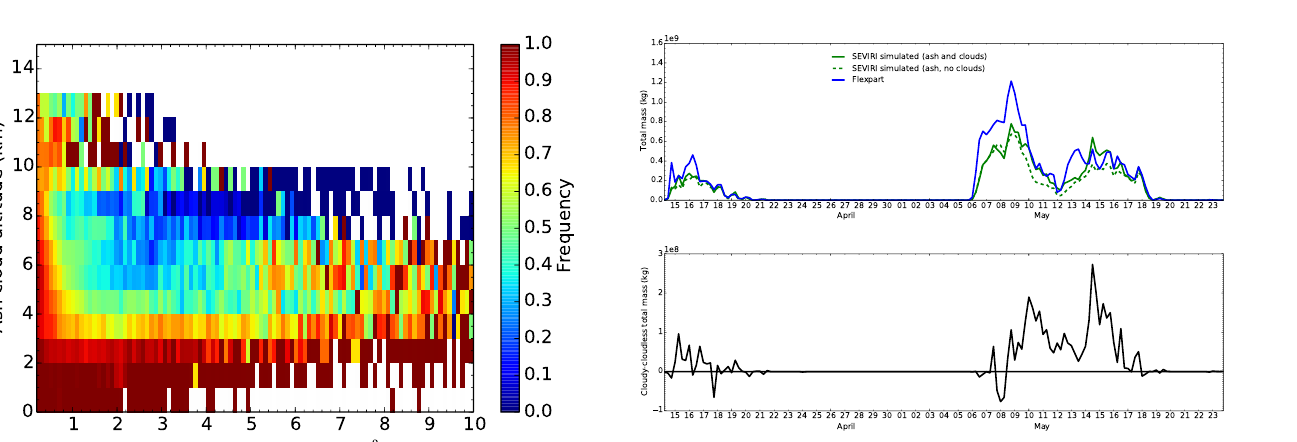
Figure11. AshretrievaltimeseriesfortheEyjafjallajökull2010eruption:TotalashcloudmassfromtheFlexpartmodel(blueline)andas Figure 11. Ash retrieval time series for the Eyjafjallajökull (2010) retrievedfromsimulatedcloudless(greendashedline)andcloudy(greensolidline)SEVIRIscenes(top).Thedifferencebetweenthecloudy andcloudlesssimulationfromtheaboveplot(bottom).Notethatonlycoincidentpixelsareincludedinbothplots. eruption: total ash cloud mass from the Flexpart model (blue line) and as retrieved from simulated cloudless (green dashed line) and eruption 3.6% (10%) of the ash pixels above the low con- 610 of theeruption, see Figs.12 and13. For thecoincident pix- cloudy (green solid line) SEVIRI scenes (top). The difference be- taminationlimitaredetectedforthecloudy(cloudless)sim- els in Fig. 16 the cloudless (cloudy) mass overestimates the ulation. If a limit of 1.0 g/m 2 is used the number of pixels Flexpartmassby28%(24%).Thisisoppositetotheunder- tween the cloudy and cloudless simulation from the above plot (bot- identified as ash increases to 4.8% (15.1%) for the cloudy estimation we found in section 4.1 for the Eyjafjallajökull tom). Note that only coincident pixels are included in both plots. (cloudless)simulation. 2010eruption.However,forshortertimeperiods,14-16May, 635 The dependence of Flexpart ash pixels and detected and 615 overestimateswerealsopresentfortheEyjafjallajökull2010 falsepositivepixelsonviewingangleispresentedinFig.14. eruptionFig.11. AsfortheEyjafjallajökull2010eruption,Fig.9,thenumber of false positives increases strongly with viewing angle and is larger for the cloudless than the cloudy simulation. The ond (5–21 May) eruption periods, being 13.0 % ± 9 % and frequency of false negatives as a function of ash mass load- 620 5 Discussion ingandashcloudaltitudeisgiveninFig.15.Thepatternis similiartotheEyjafjallajökull2010eruption.Mostashpix- The detection of ash affected pixels depends on the dif- elsthatmissdetectionareeitherataltitudeslowerthan4km ference between the surface temperature and the ash cloud 640 these numbers are 25.2 % ± 17.0 % and 21.4 % ± 16.0 %, orhaveamassloadinglessthan0.5g/m 2 .Atthestartofthe temperature. The effective ash emissions were generally at eruptiontheplumetravellednorthwardsataltitudesofabout 625 higher (about 6 km) altitudes for Eyjafjallajökull compared 10-12km.Thepixelsmissedatthisaltitudehaveatoosmall toGrímsvötn(2-3km,exceptfor22May),seeFig.2inStohl massloadingtobedetected. etal.(2011)andFig.3inMoxnesetal.(2014),respectively. The total ash cloud mass for coincident pixels is shown TheoverallloweraltitudeoftheGrímsvötnashexplainswhy 645 in Fig. 16. Only data up to 24 May is shown as for the relativelylessofitwasdetectedinthesimulationspresented cloudysimulationashisdetectedonlyforthefirstfewdays 630 inSection4,duetosmallertemperaturedifferencesbetween